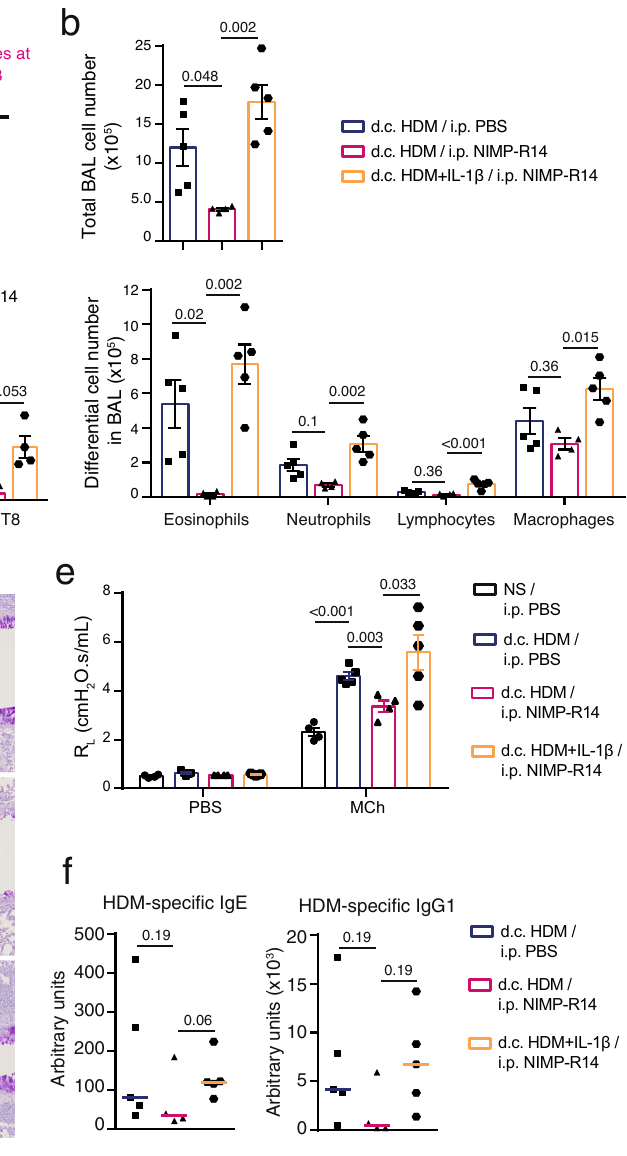
Fig. 7 | Administration of IL-1 β restores the d.c. HDM-induced asthmatic phe- notypeinNIMP-R14-treatedmice.a Experimentalprotocol.WildtypeBalb/cmice were intraperitoneally (i.p.) injected with PBS or NIMP-R14 antibody at day (D) -1 andD2.Micewered.c.sensitizedwithHDM±IL-1 β onLMP_91 μ mearsatD0andD3. All mice were intranasally (i.n.) challenged with HDM from D9 to D12 and analysed at D13. b Total cell number and differential cell counting in BAL fl uid ( n =5, 4, 5 mice). One-way ANOVA test. c Relative RNA levels of genes in BAL cells ( n =5, 4, 4 mice). One-way ANOVA test. d Lung sections were stained with hematoxylin-eosin